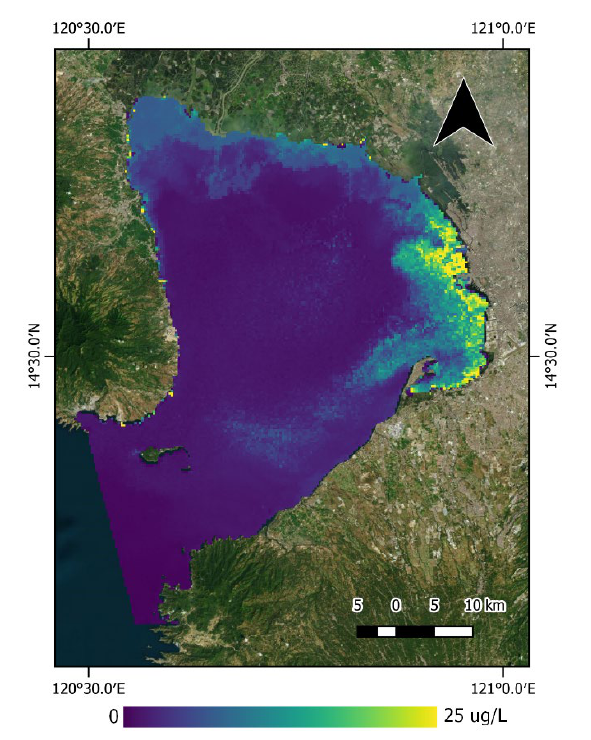
Figure 5. TNDCI Chlorophyll-a (March 29, 2020)